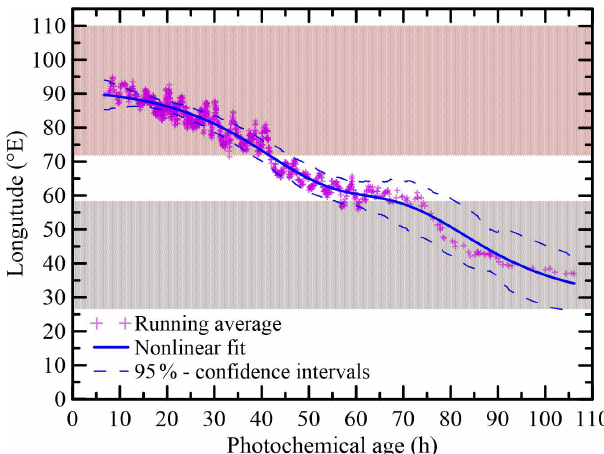
Figure 6. Dependence of the longitude of the instant location of a given BB plume on its photochemical age. The shaded areas indi- cate the ranges of longitudes of the source (red shade) and receptor (brown shade) regions shown in Fig.